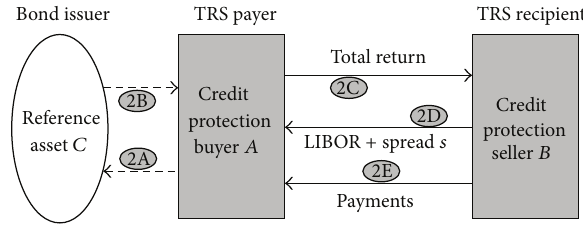
Figure 1: The structure of